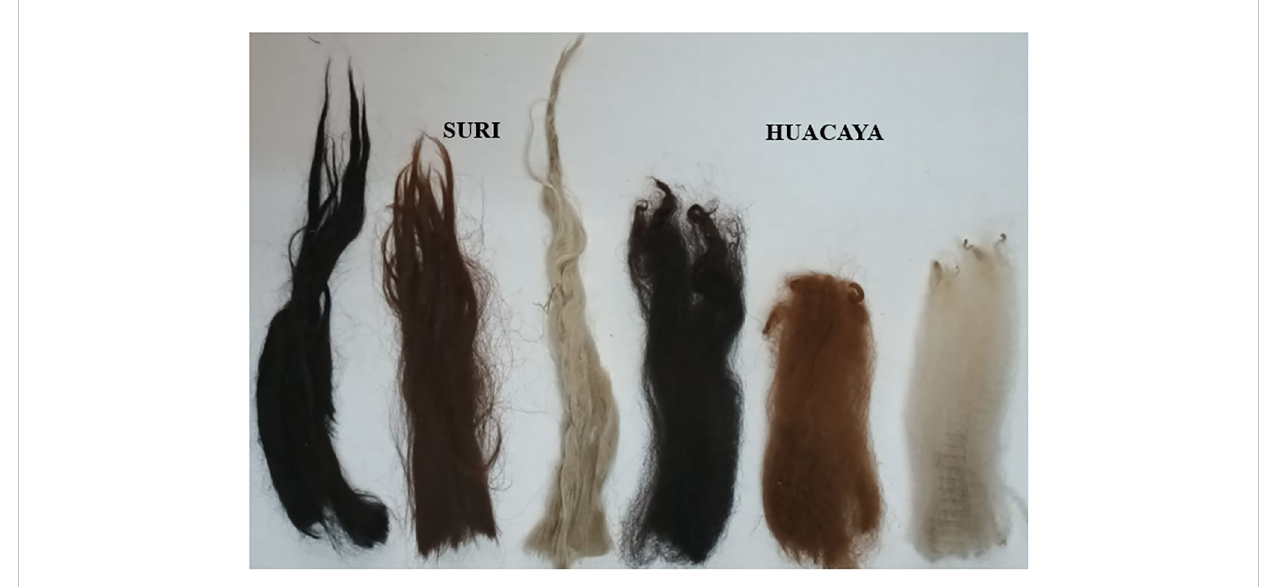
FIGURE 1 Color of alpaca fi bers sampled. Suri (left) and Huacaya